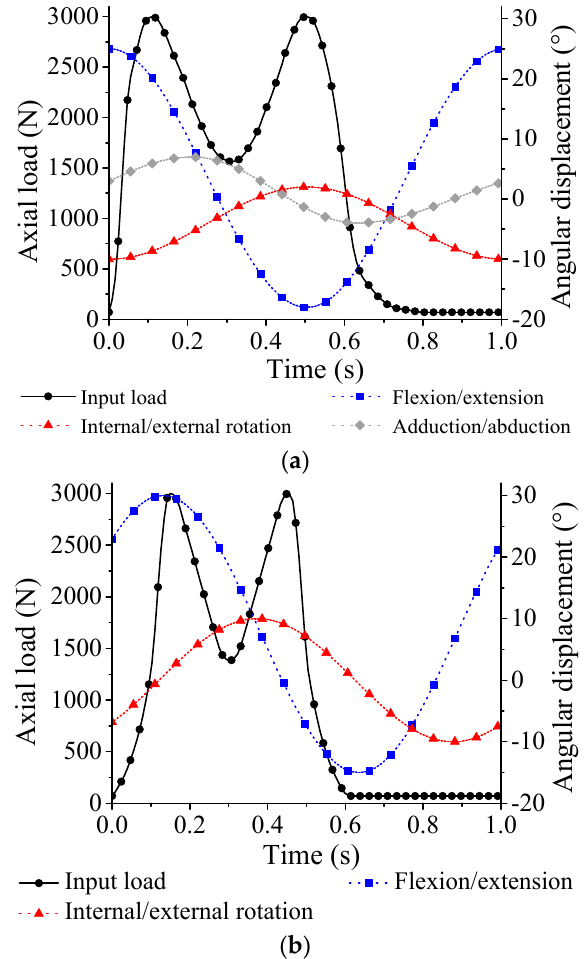
Figure 2. Joint simulator input profiles for ( a ) three axes of rotation and ( b ) two axes of rotation conditions [24,25].